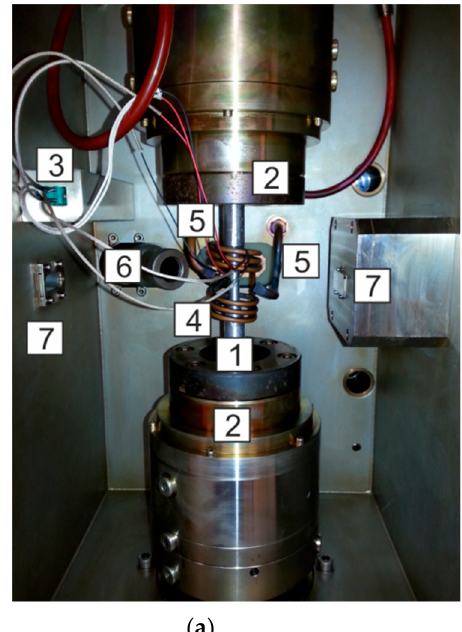
Figure 3. STD 812 torsion plastometer: ( a ) device chamber: 1—specimen, 2—holders, 3—thermocouples type S, 4—induction solenoid, 5—cooling system jets, 6—pyrometer, 7—sensors for laser measurement of specimen diameter and ( b ) basic specification [2,27]. for laser measurement of specimen diameter and ( b ) basic specification